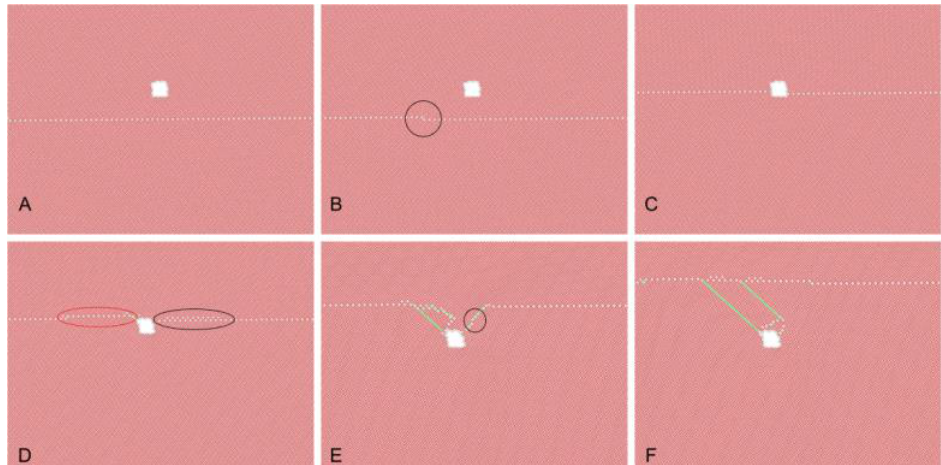
Figure 4. Interaction of the migrating twin boundary with the void: ( A ) initial configuration; ( B ) migration of the pre-existing disconnection along the boundary. The disconnection is marked by a black circle; ( C ) the boundary is blocked in the void; ( D ) nucleation of disconnection dipoles in the boundary and subsequent absorption of disconnections by the void surface; The dipoles are marked by ellipses. The red ellipse marks the already developed dipole and the black ellipse marks the location of dipole nucleation in progress. ( E ) formation and migration of basal-prismatic interfaces. Disconnection on the basal-prismatic interface is marked by a circle; ( F ) detachment of the boundary from the void with the formation of two basal stacking faults. The projection of the figure is in the [1210] direction. The atoms in the boundary are colored in white and atoms in stacking faults are colored in green.